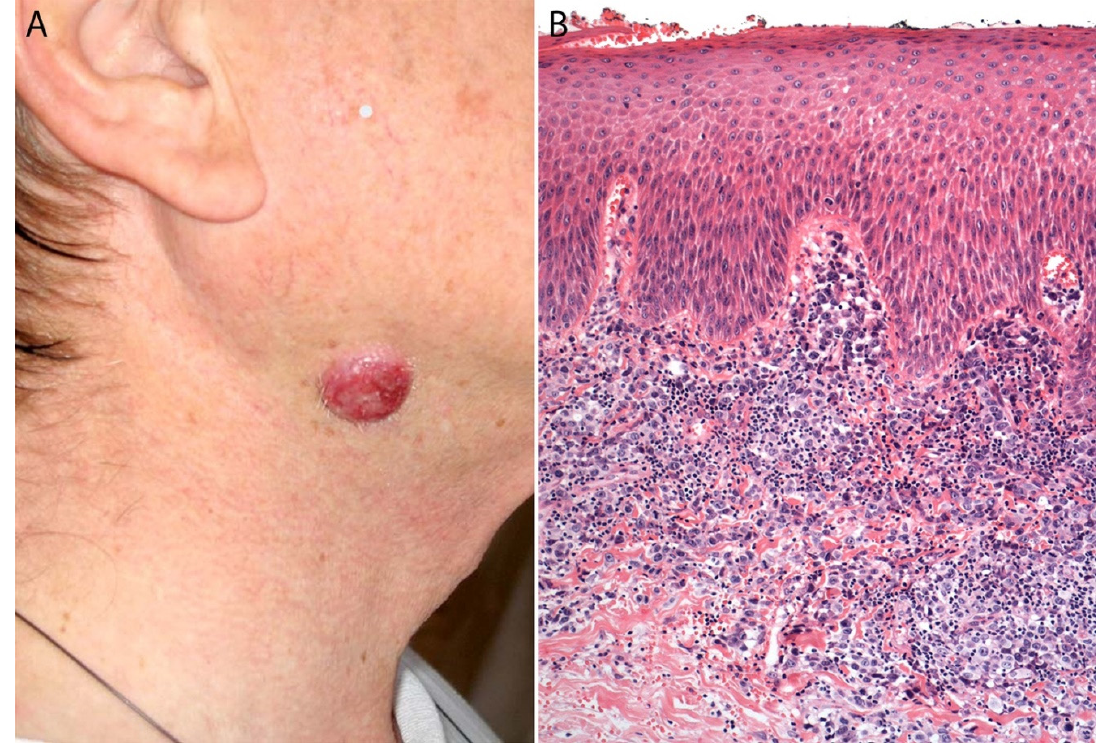
Figure 11. ( A ) Primary cutaneous ALCL. A 45-year-old man presented with a single cutaneous erythematous nodule located in the neck. ( B ) Microscopically, the nodule consists of a non-epidermotropic atypical lymphoid infiltrate with diffuse dermal involvement.